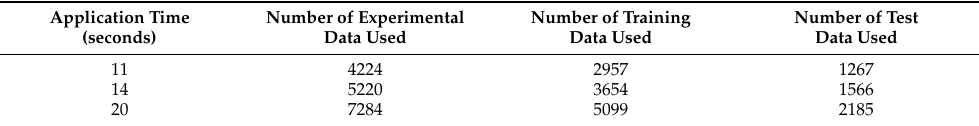
Table 3. The force values that occurred according to the variable pressure